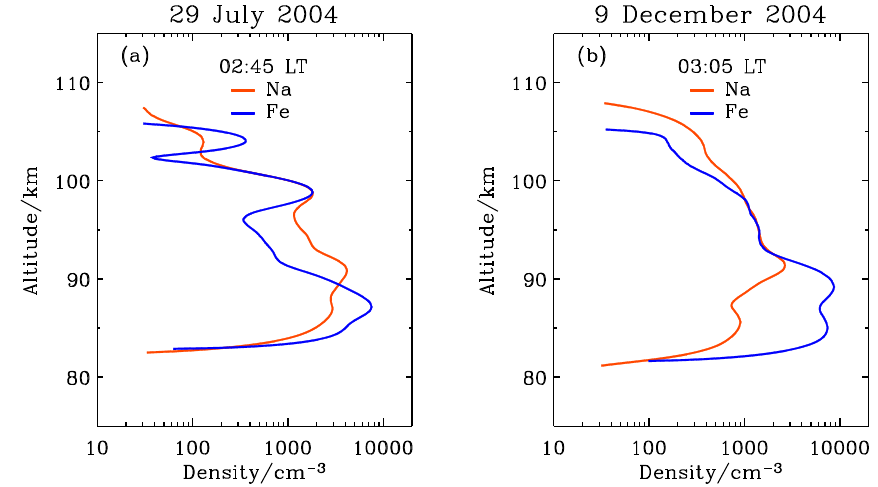
Fig. 1. Simultaneous 5-min Na and Fe density profiles measured at (a) 02:45LT on 29 July 2004 and (b) 03:05LT on 9 December 2004. The two examples represent some ubiquitous features of simultaneously observed Na and Fe layers: the upper boundary of the Na layer is a few kilometers higher than that of the Fe layer, while the lower boundary of the Na layer is several hundred meters lower than that of Fe layer. Both the Na and Fe layers have much steeper density gradients on the bottom side than on the top side, and the borders of the Fe layer are obviously steeper than those of the Na layer. Note the density criterion is taken to be 30cm − 3 uniformly for both Na and Fe according to their thresholds.